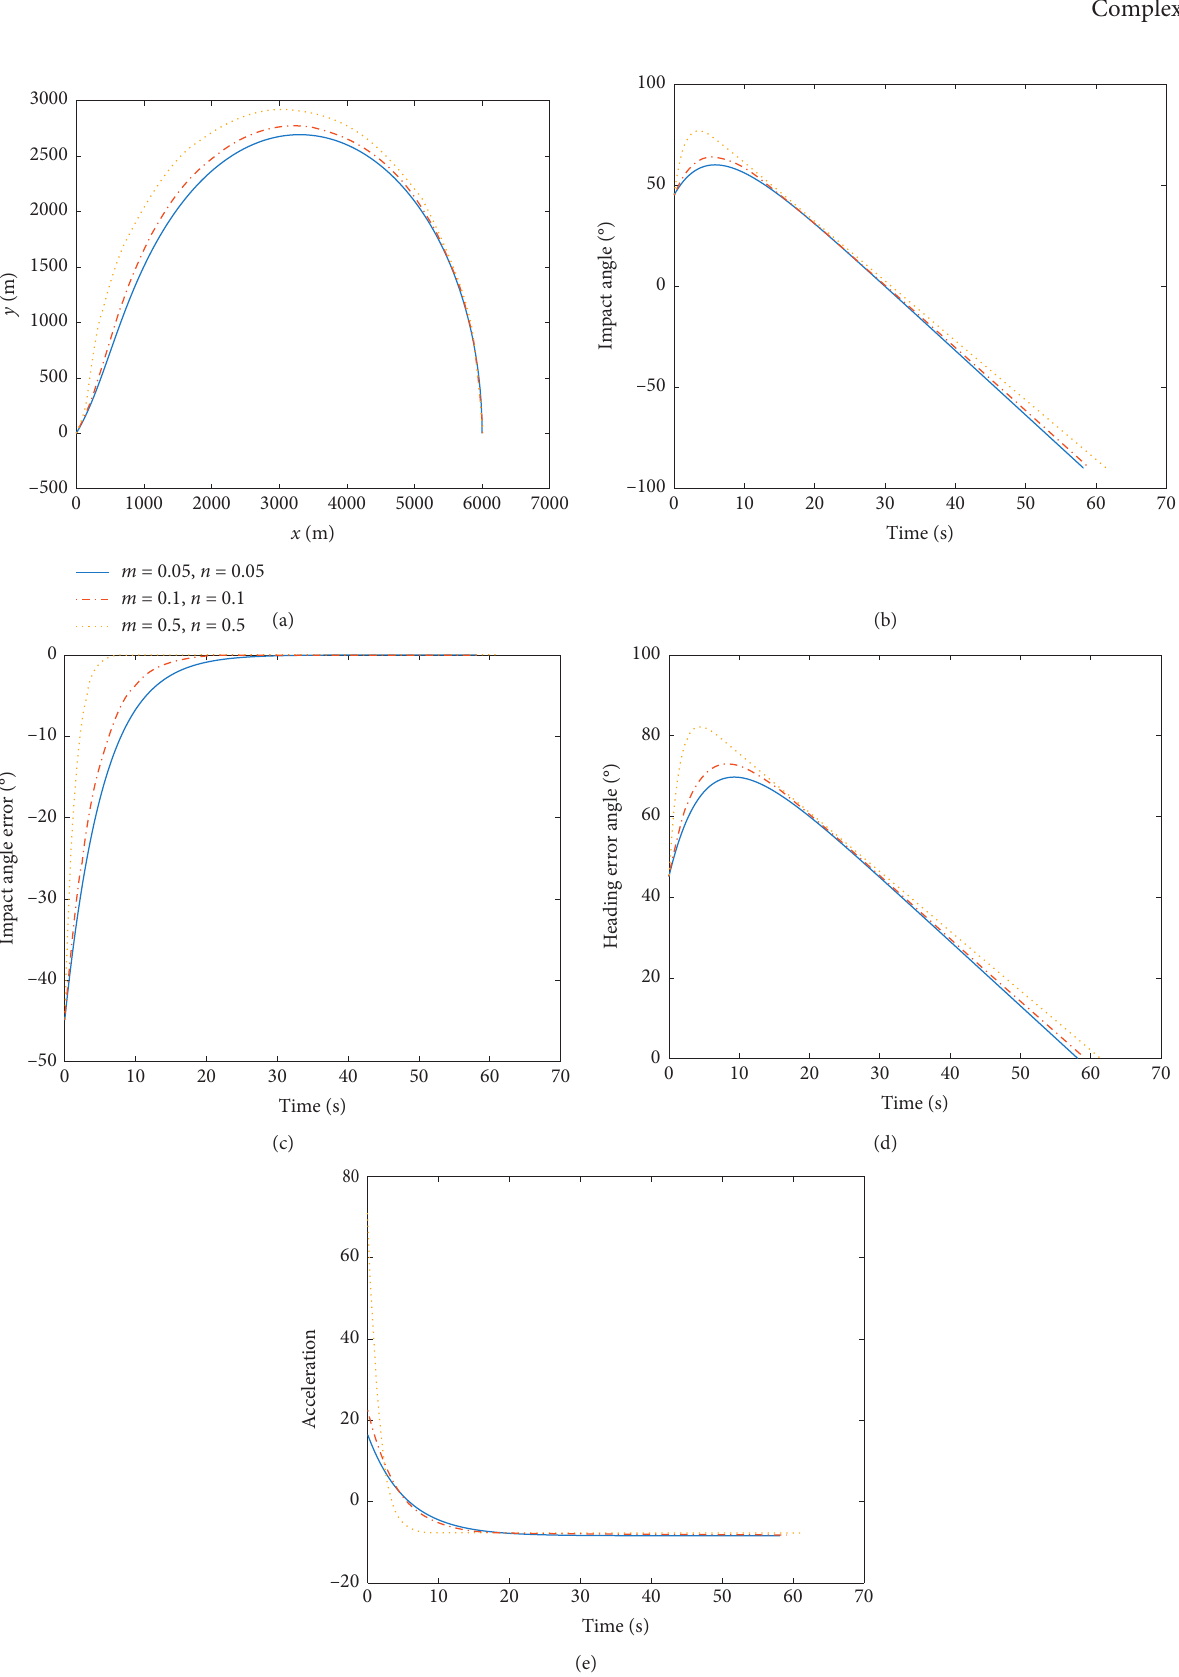
Figure 6: Various control parameters with the same impact angle. (a) Trajectories. (b) Impact angle. (c) Impact angle error. (d) Heading error angle. (e)